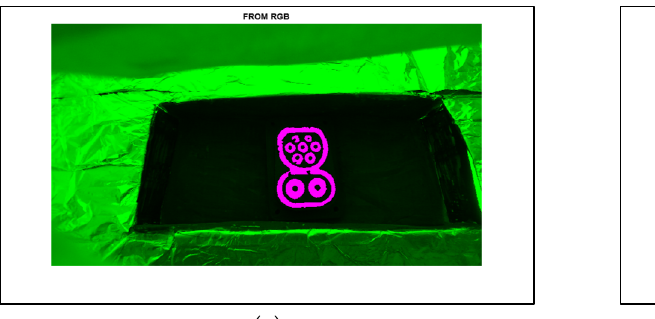
Figure 9. ( a ) Overlapped image of the extracted CCS2 socket and ( b ) marked centroid coordinate of the CCS2 socket in the original input image.